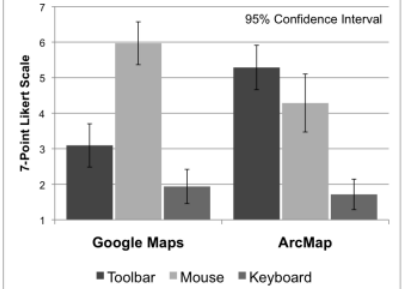
Figure 9. Frequency of use of traditional techniques to perform map navigation tasks (1=never using, 7= very often using).